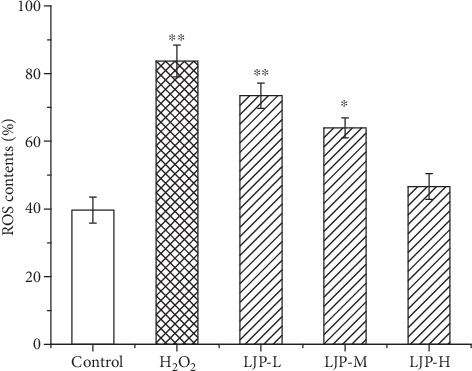
Effect of LJP on the ROS contents in cardiomyocytes. ROS of cardiomyocytes was detected by flow cytometry. Cardiomyocytes were incubated with different concentrations of LJP (10, 20, and 40 μg mL−1) for 12 h. Control group was added 100 μL DMEM medium. H2O2 model group was added H2O2 (200 μmol L-1) 100 μL. Then, the ROS contents in cardiomyocytes were determined. The results are expressed as mean ± SD (n = 10). Statistical significance was determined by One-Way Analysis (ANOVA). ∗P < 0.05, ∗∗P < 0.01 versus control groups.